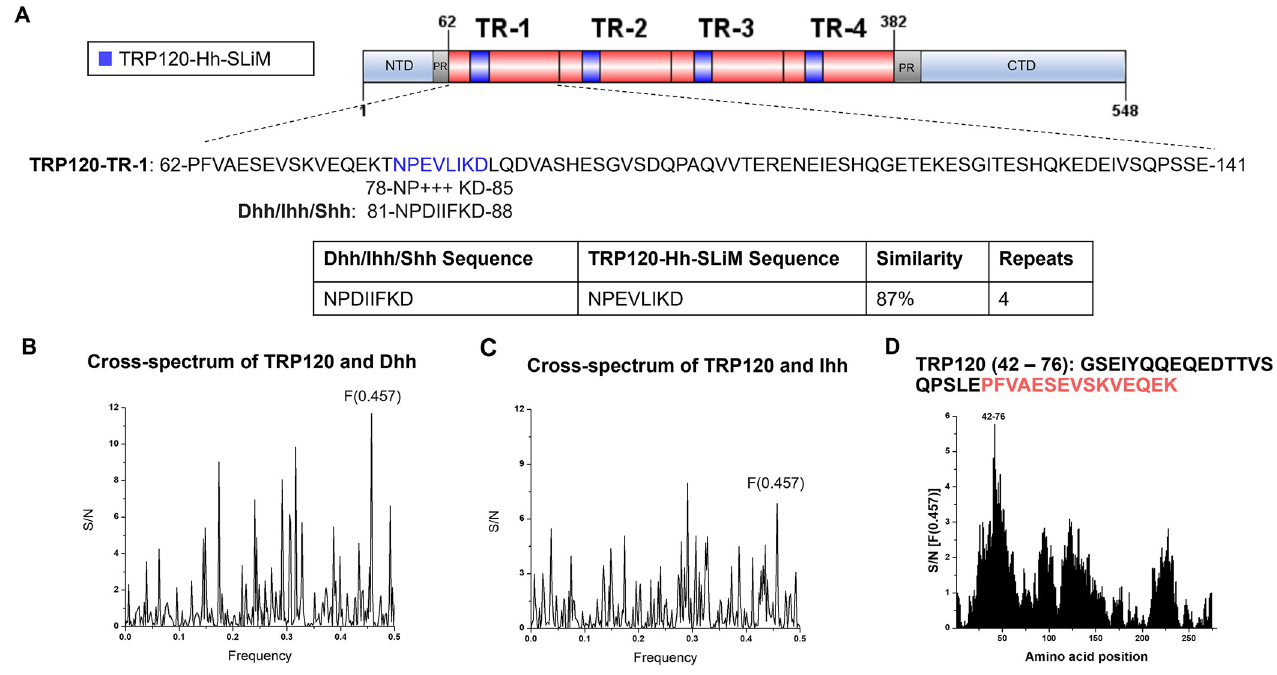
Fig 1. TRP120 TR motif shares sequence and functional similarity with Hh ligands. (A) Schematic representation of TRP120 showing domain organization. TRP120 consists of a N-terminal (NTD), C-terminal (CTD) and tandem repeat (TR1–4; 80 aa each) domain, flanked with two partial repeats (PR) [89]. NCBI Protein BLAST identified an 8 amino acid short linear motif (SLiM) of high similarity between the TRP120 TR and Hh ligand amino acid sequences corresponding to the location of Hh ligand and Hh PTCH receptor-binding site [39,63].Complete amino acid sequence of one TR is shown with homologous Hh SLiM identified in blue. Blue shaded TR regions shown in schematic indicate location of Hh SLiM. Table summarizes amino acid sequence similarity between Hh ligands and TRP120; (B-D) ISM analysis of TRP120 and Dhh/Ihh; (B) Cross-spectrum of TRP120 (accession no. AAO12927.1) and Dhh (NP_066382) with ISM frequencies (x axis) plotted against normalized amplitude for each component (y axis); (C) Cross-spectrum of TRP120 and Ihh (NP_002172) with ISM frequencies (x axis) plotted against normalized amplitude for each component (y axis); (D) Scanning of the amino acid sequence of Dhh/Ihh along ISM F[0.457] immediately upstream of the TRP120-Hh-SLiM. The TRP120 TR region is defined in red.